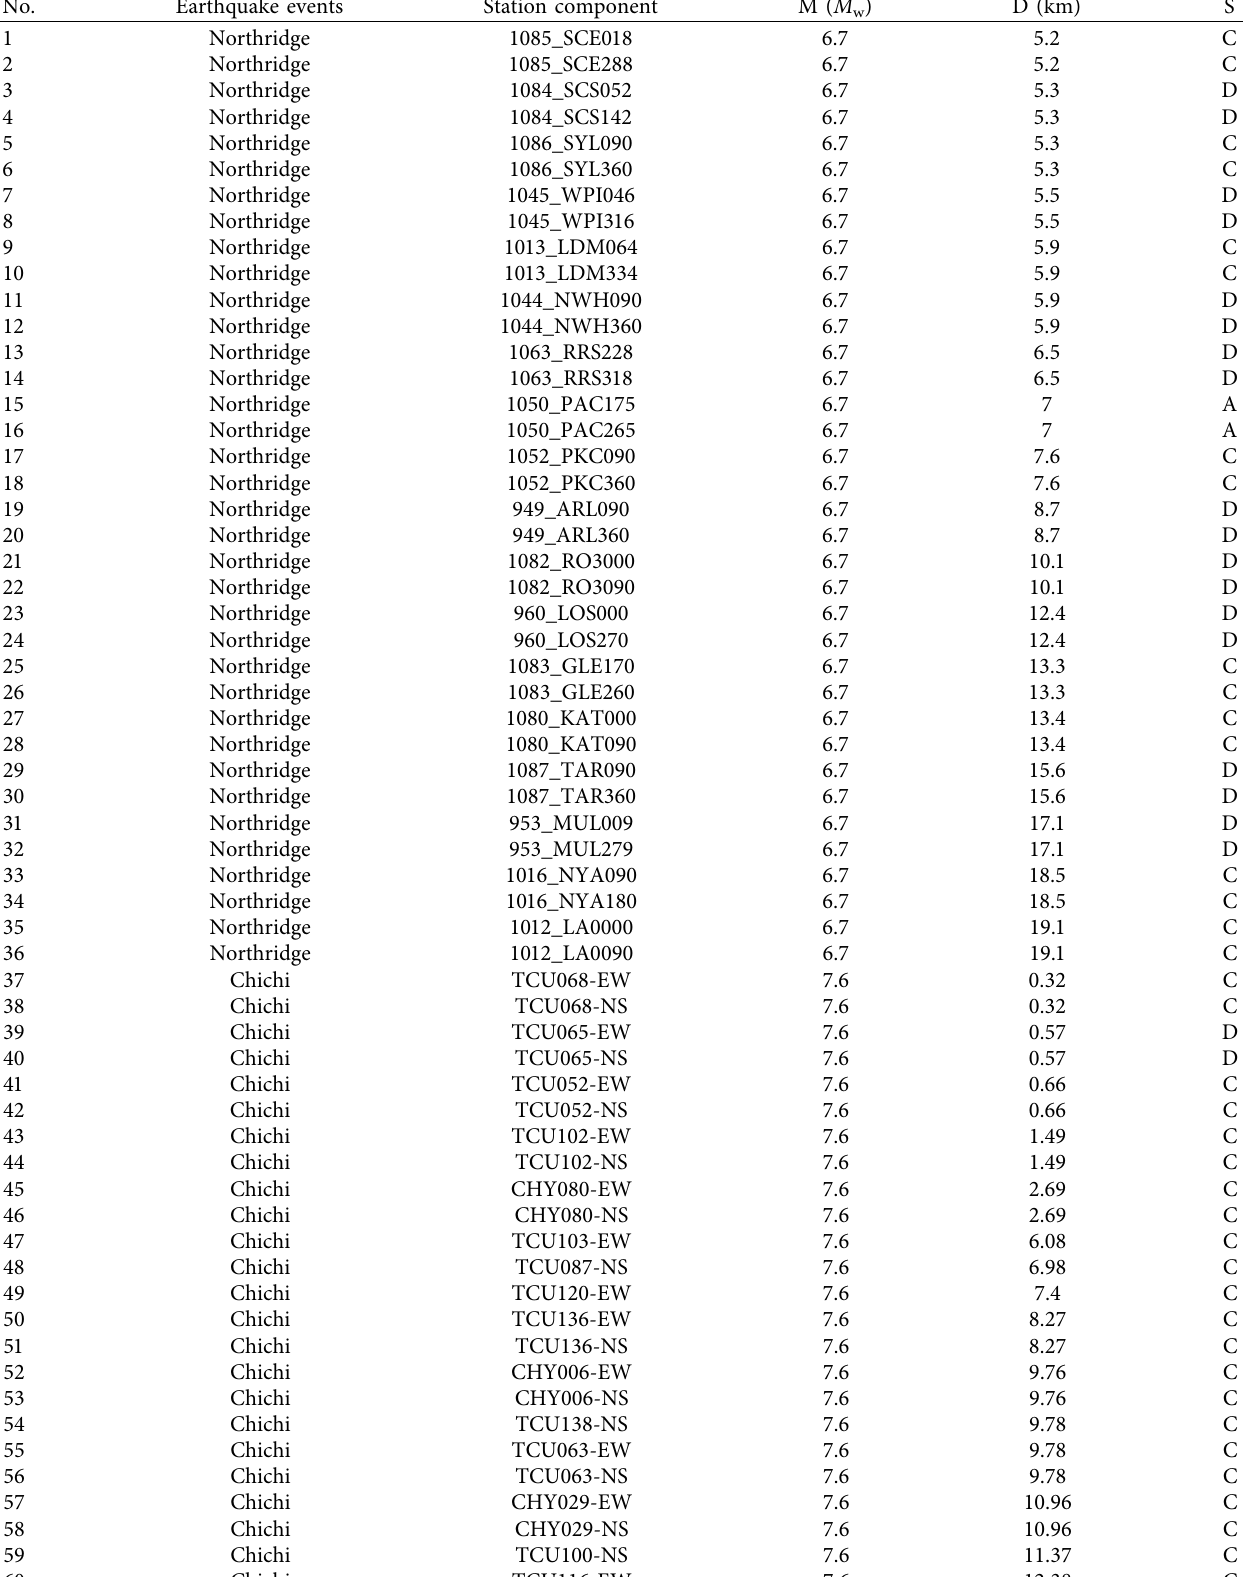
Table 1: Basic information of near-fault pulse-like earthquake